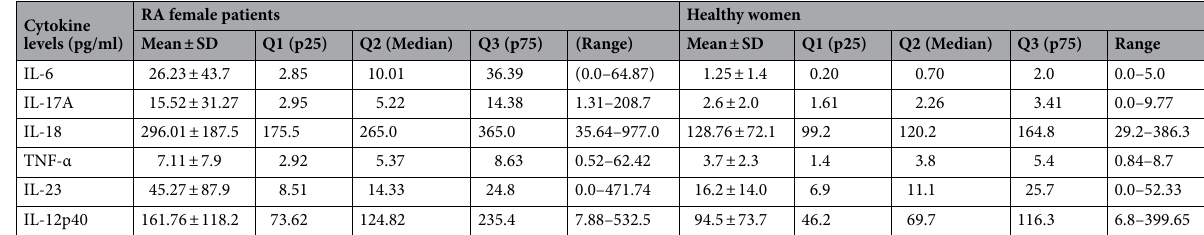
Table 1. Serum cytokines in RA female patients and healthy women.